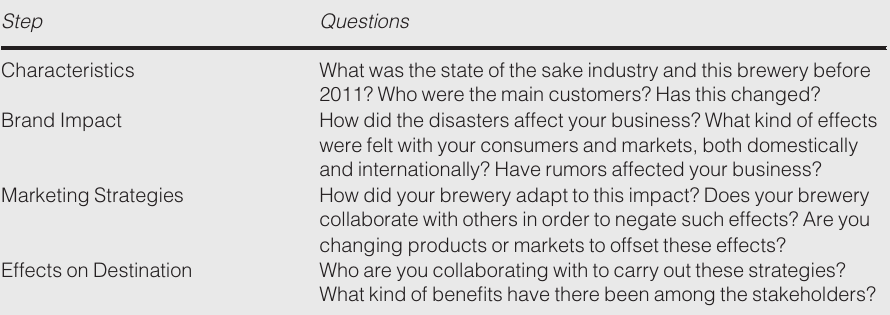
Table 1 Interview questions used to answer each step of the multi-step